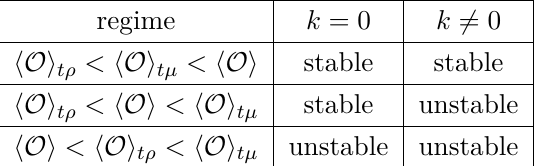
Table 1 . Summary of the results of the QNMs analysis for the 1st order phase transition. hOi tρ and hOi tµ are respectively the condensate values of turning points in the canonical and grand canonical ensembles (see the left panel of figure 13). k = 0 refers to homogeneous linear perturbations and k 6 = 0 to inhomogeneous